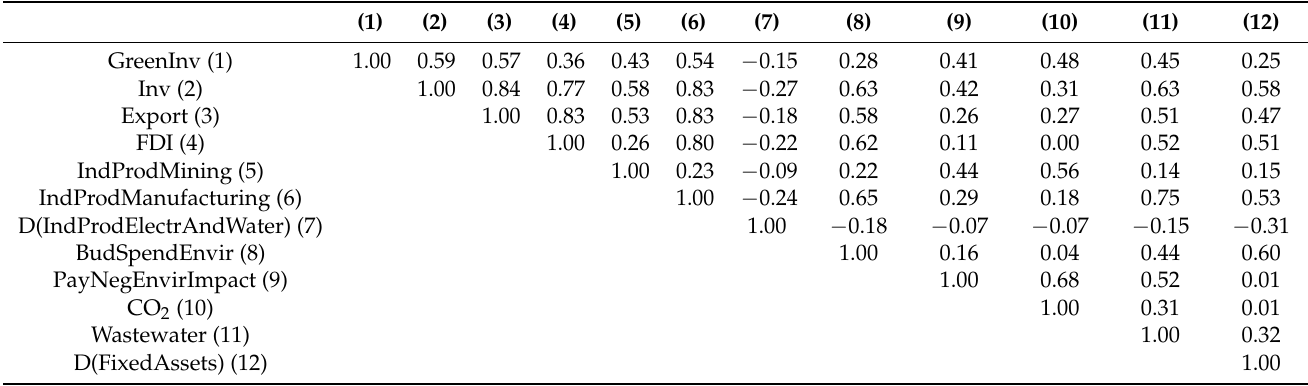
Table 3. Pair correlation